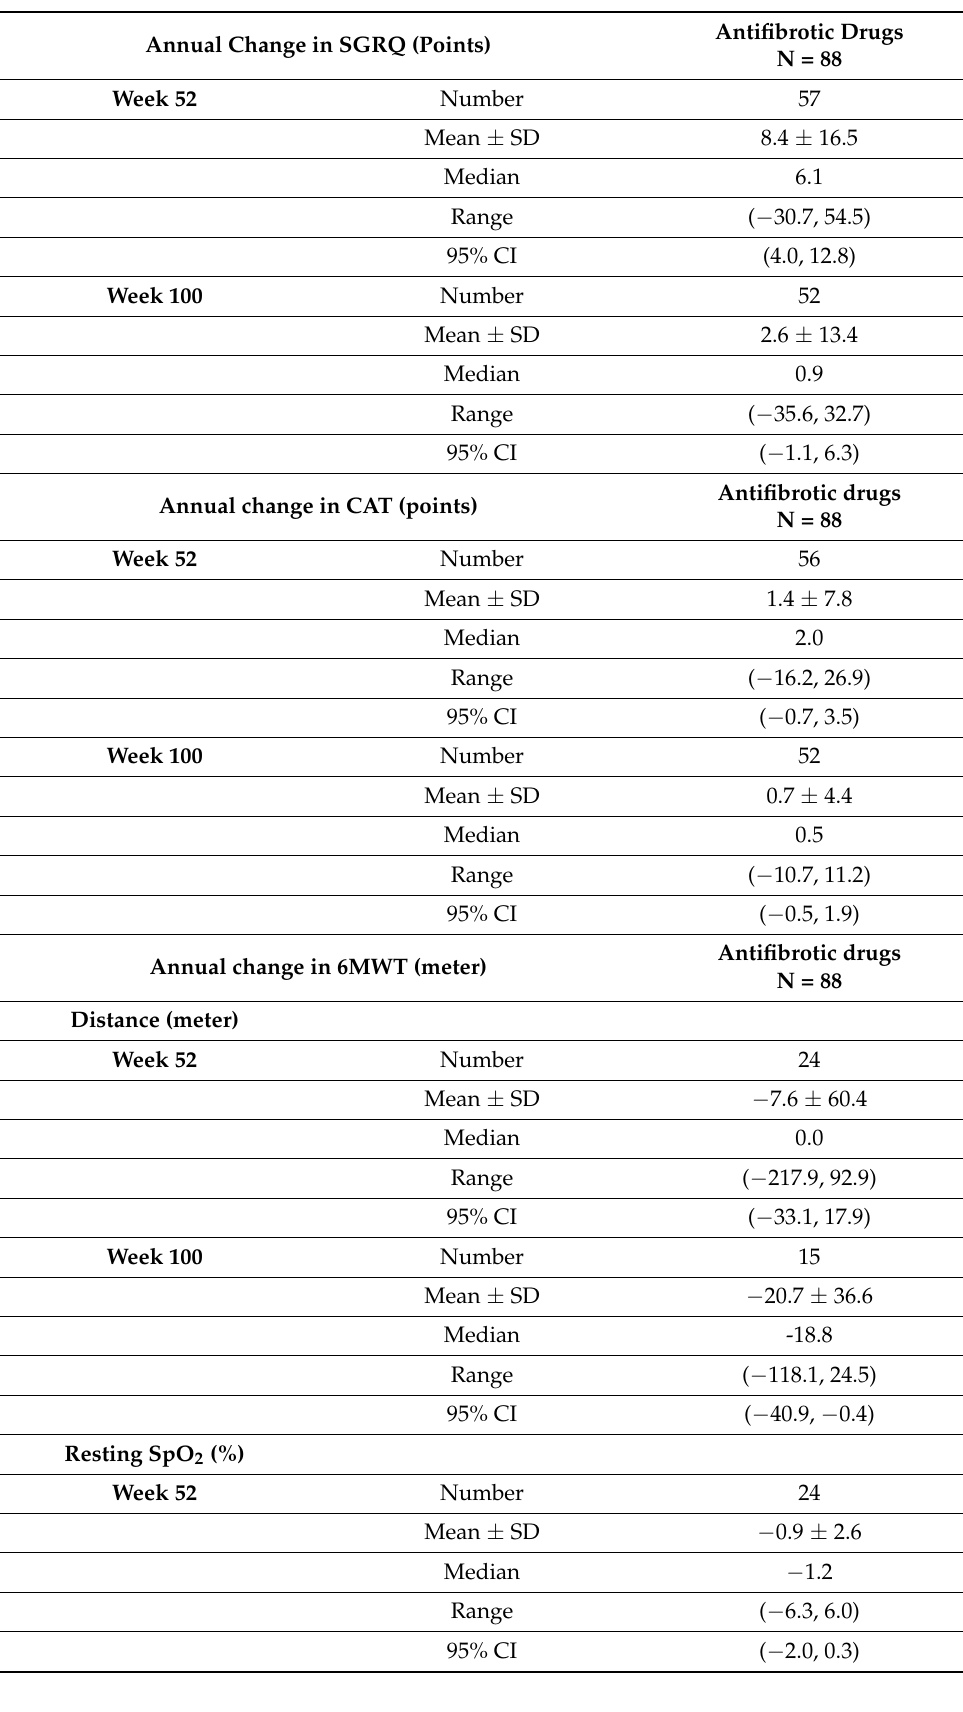
Table 6. Summary of annual change from baseline for secondary